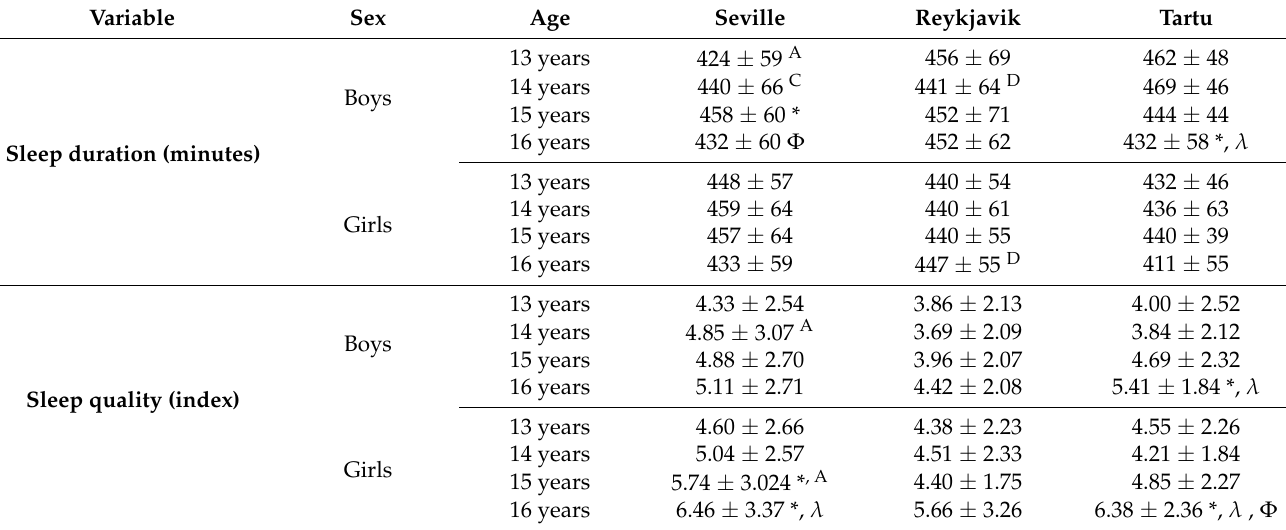
Table 3. Sleeping duration and quality in boys and girls by age in the three